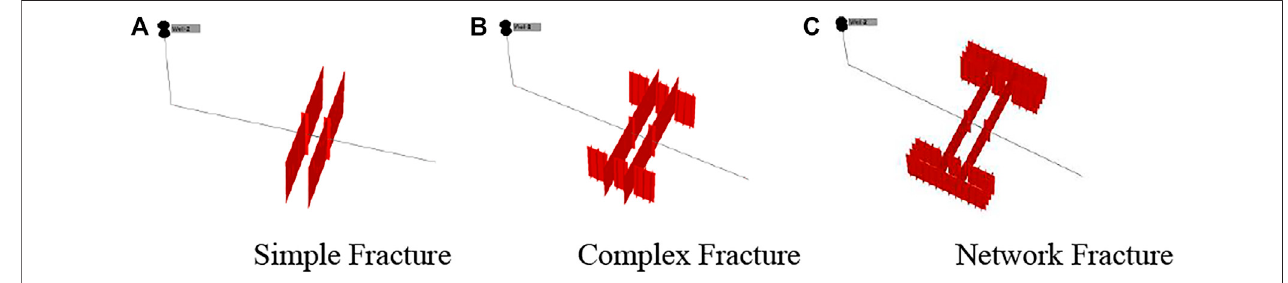
FIGURE 13 | Simulated diagrams of different fracture shapes. (Red areas in the fi gure (A – C) denote for the fracture systems.)